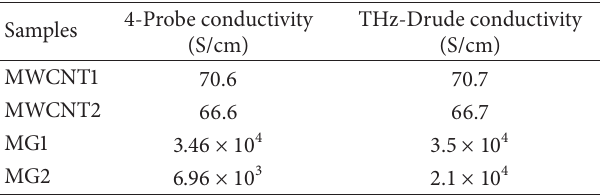
Table 1: DC conductivity obtained using 4-probe technique and determined from THz Drude